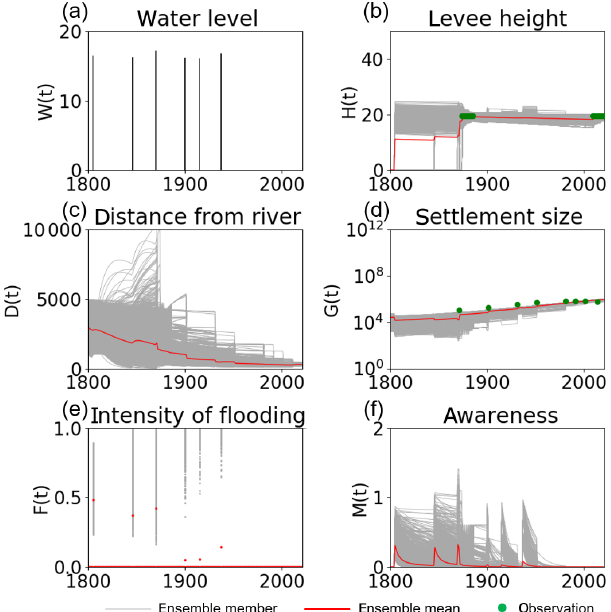
Figure 12. Time series of (a) the high water level W(t) , (b) the flood protection level (or levee height) H(t) , (c) the distance of the center of the mass of the human settlement from the river D(t) , (d) the size of the human settlement G(t) , (e) the intensity of flooding events F(t) , and (f) the social awareness of the flood risk M(t) simulated by 5000 ensembles, with uncertain high water levels and no data assimilation in the real-world experiment in the city of Rome. The time step is annual. Gray and red lines are the ensemble members and their mean, respectively.